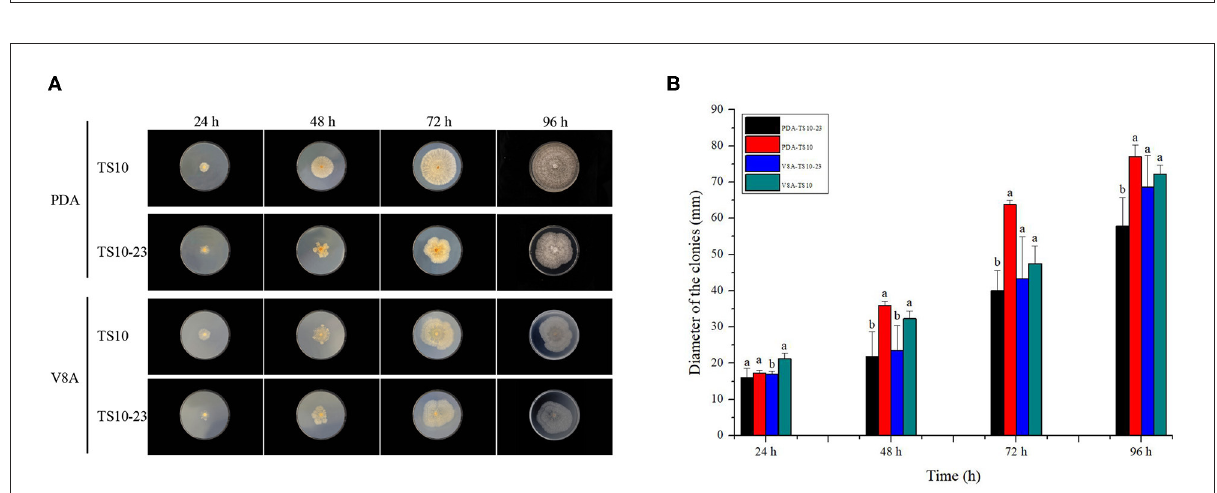
FIGURE5 Growth phenotype of TS10 (RsPV433 free) and TS10-23 (RsPV433 infected) R. solani strain. (A) Growth phenotype of TS10 and TS10-23 on PDA and V8A medium at 25 ◦ C in dark for 4 days. (B) Comparison of the average radial mycelial growth rates between TS10 and TS10-23 on PDA and V8A,